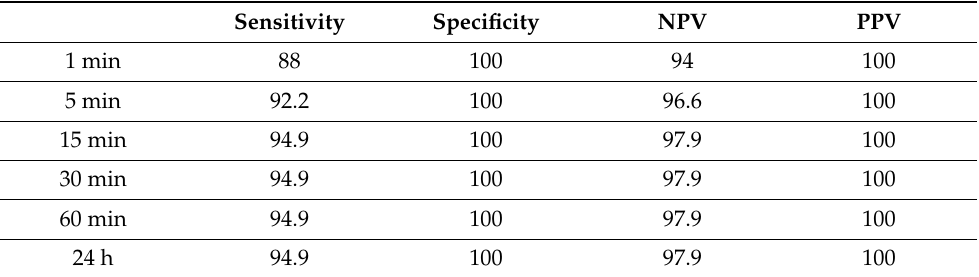
Table 5. Sensitivity, specificity, negative predictive value (NPV) and positive predictive value (PPV) of the iNatal duo test in patients taking